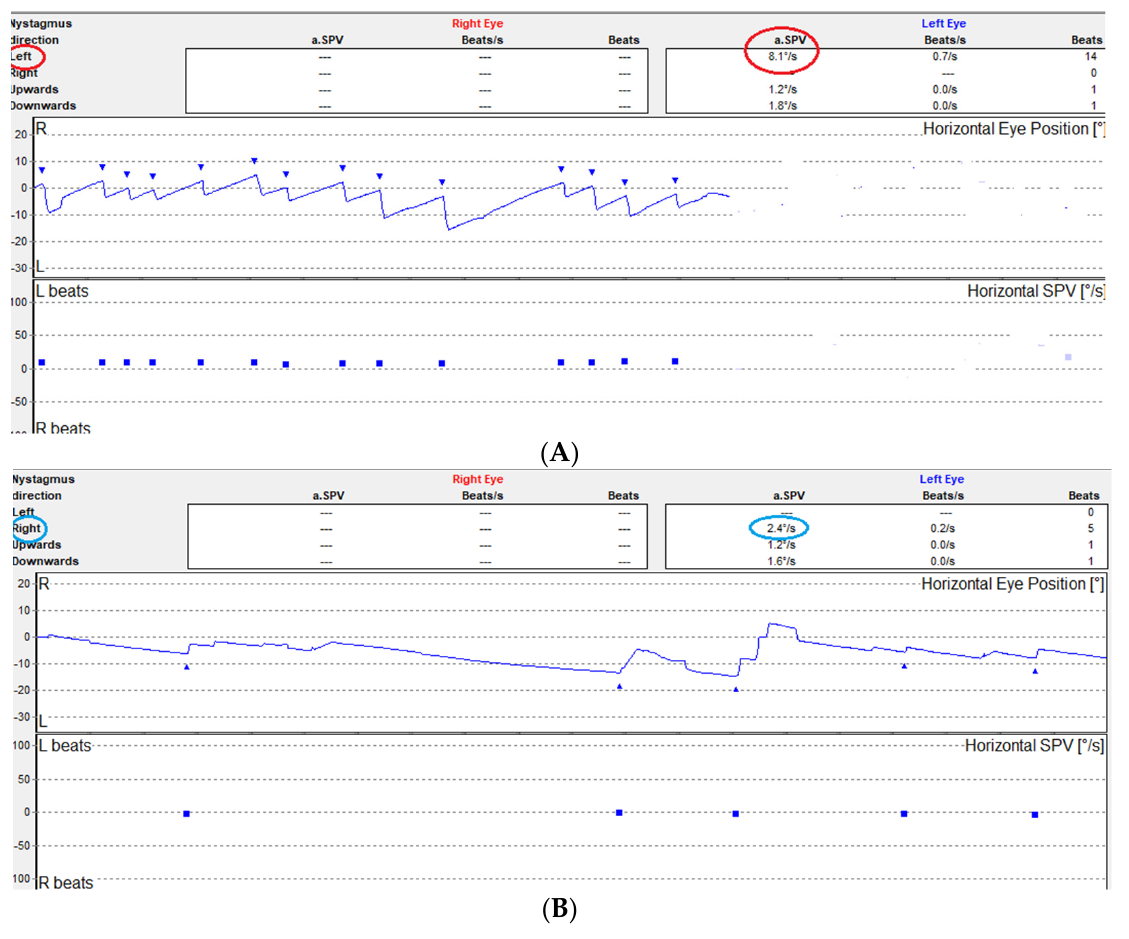
Figure 1. ( A ) Spontaneous nystagmus recorded with absence of fixation 48 h after the vestibular insult (first consultation). ( B ) Recovery spontaneous nystagmus recorded with absence of fixation seven days later (second consultation). Table 1. Spontaneous nystagmus and caloric responses in the first and follow-up consultations of the patient. Time from Vestibular